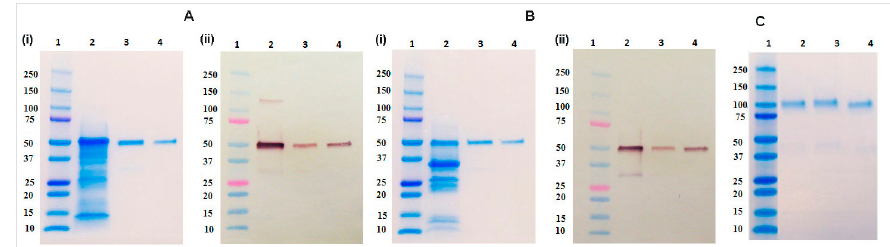
Figure 4. SDS-PAGE, immunoblot, and non-reducing gel analysis. ( A ) Whole leaf extracts and ( B )